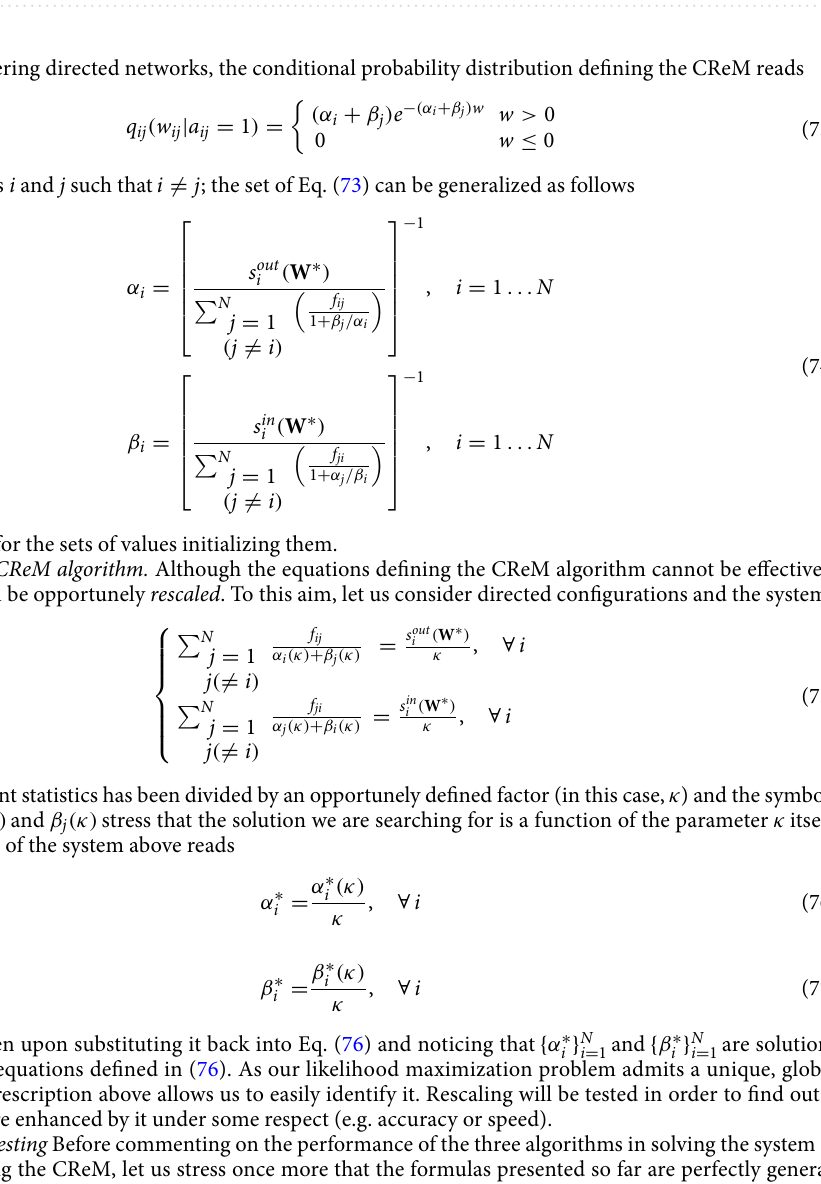
8 L ( 10 θ) is satisfied, the quasi-Newton one often 2 − � ||∇ || ≤